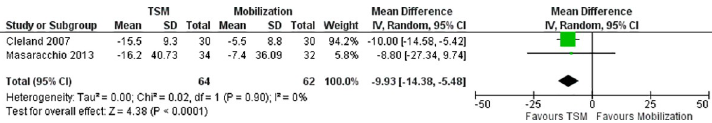
Fig 7. Meta-analysis for TSM versus mobilization for disability without a distinction between immediate and short-term follow-up.